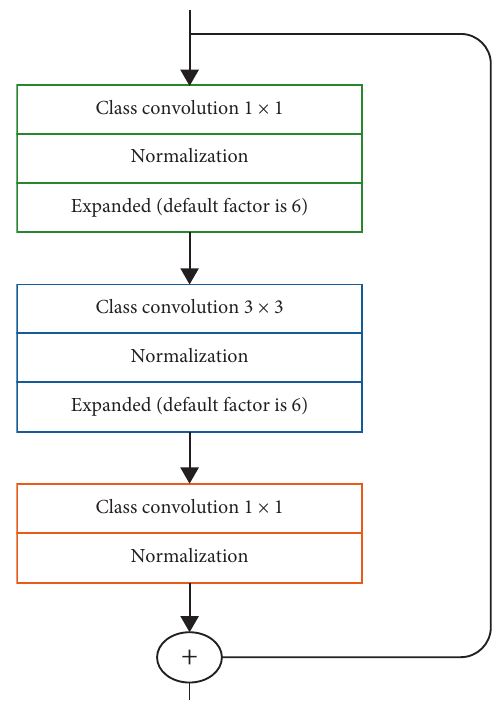
Figure 6: Model of MobilenetV2